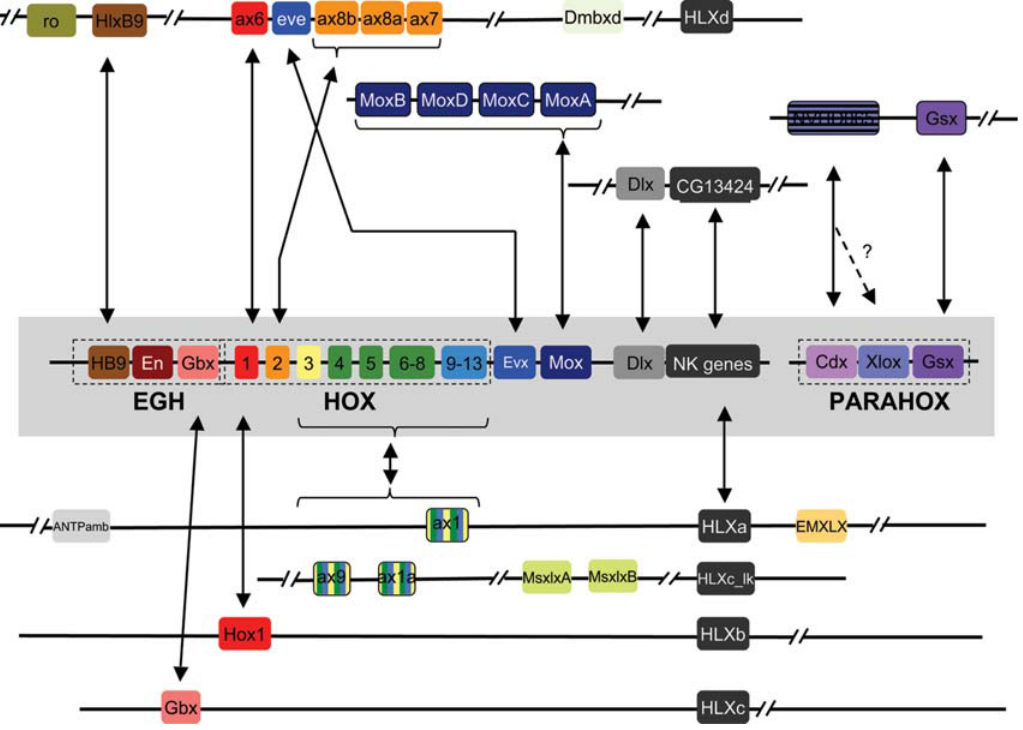
Figure 3. Clusters of Hox-related homeobox genes in the Nematostella genome. Based on the current genomic assemblies, thirty ANTP class genes of Nematostella are distributed among seven homeobox clusters [52]. The location of the PRD class gene Dmbx is also shown. The arrangement of the Nematostella genes is shown in relation to the hypothesized "extended Hox cluster," that is presumed to have existed in the most recent common ancestor of protostomes and deuterostomes (gray box; [127,128]). Horizontal lines connecting Nematostella genes indicate known genomic linkage. Double-arrows connect Nematostella homeodomains to their putative bilaterian homologs based on phylogenetic analyses of homeodomain sequences (Figure 1; supp figs. 1–2). Detailed diagrams of each of the eight Nematostella homeodomain clusters are presented in supplemental figures 3–10.